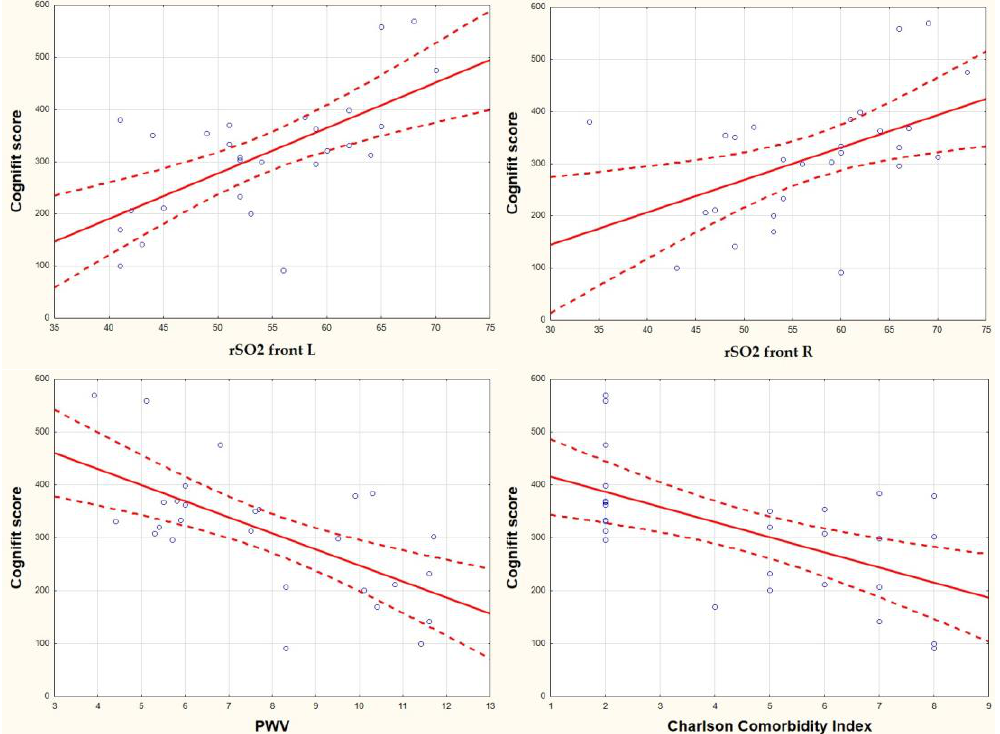
Figure 2. Correlation of the MOCA score with rSO2 front R, rSO2 front L, PWV, and CCI.